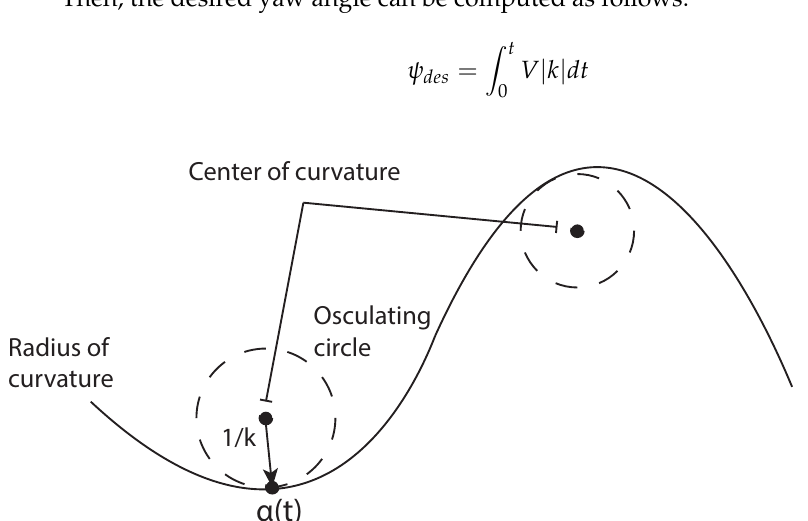
Figure 8. Osculating circle and radius of